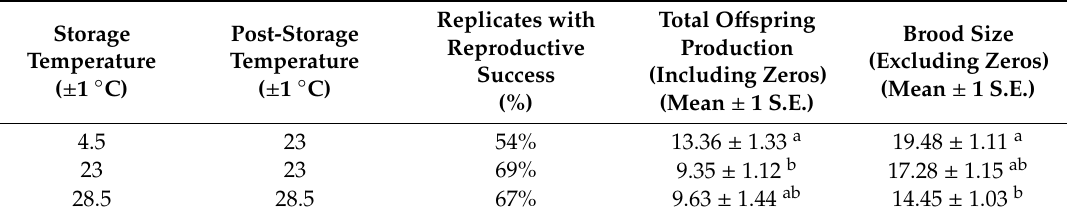
Table 6. Adult o ff spring production according to storage temperature.